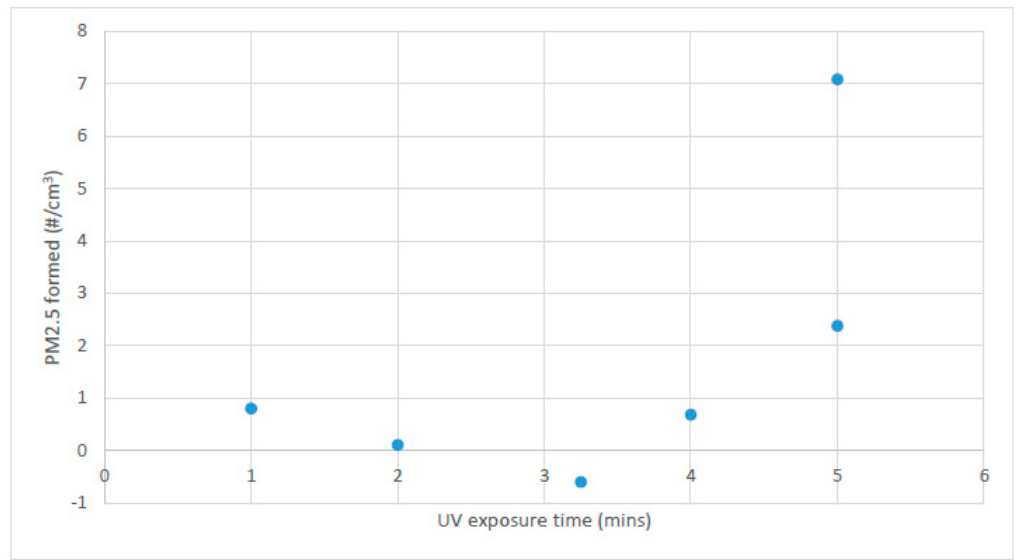
Figure 4. PM2.5 counts after a constant total time (6 min), with varying UV exposure times and duplicate experiments at 5 min.